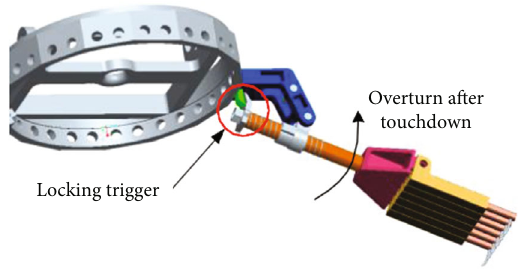
Figure 7: Initial installation status.